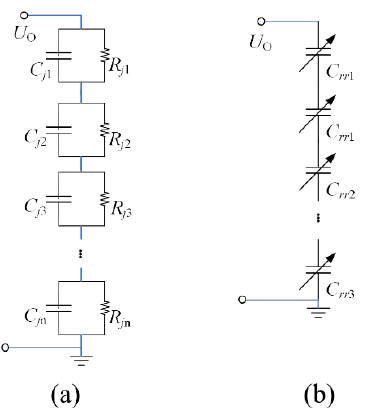
Figure 4. Equivalent circuit of series diode turn-off process: ( a ) Low-frequency equivalent circuit; ( b ) high-frequency equivalent circuit.